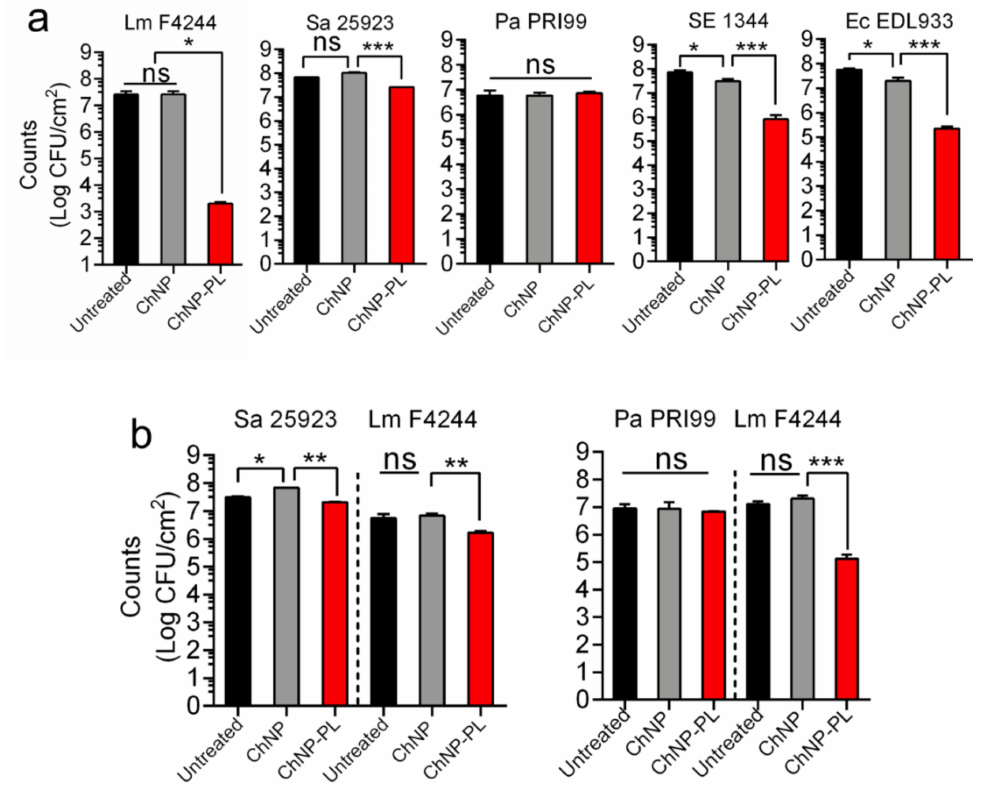
Figure 7. Assessment of inactivation of preformed biofilms of ( a ) monocultures and ( b ) mixed cultures by chitosan nanoparticles (ChNP) or chitosan nanoparticles conjugated to ε -poly-L-lysine (ChNP-PL) on five pathogens. Panels are bacterial counts of ( a ) monoculture of L. monocytogenes (Lm) F4244, S. aureus (Sa) ATCC25923, P. aeruginosa (Pa) PRI99, S . Enteritidis (SE)18ENT1344, or E. coli (Ec) O157:H7 EDL933, and ( b ) mixed culture biofilms of L. monocytogenes F4244 and S. aureus ATCC25923, or L. monocytogenes F4244 and P. aeruginosa PRI99. Bacteria isolated from biofilms were